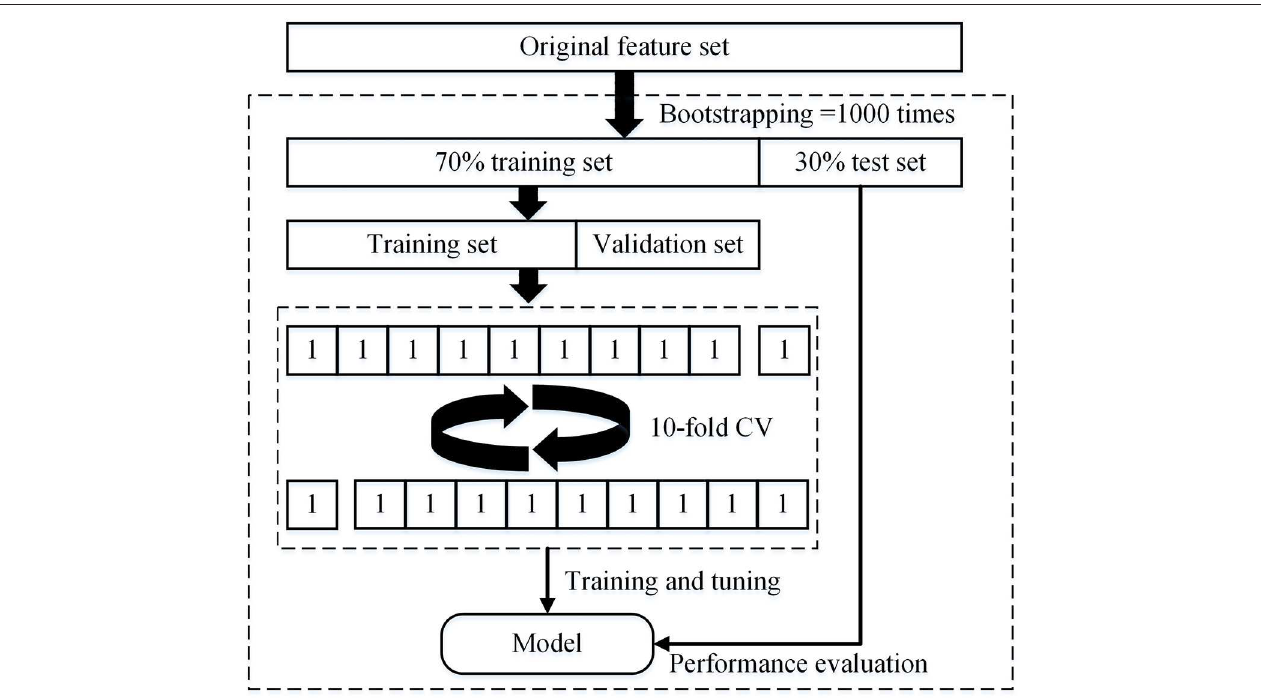
FIGURE 2 | Structure of the nested 10-fold cross-validation for evaluating the performance of machine learning models.